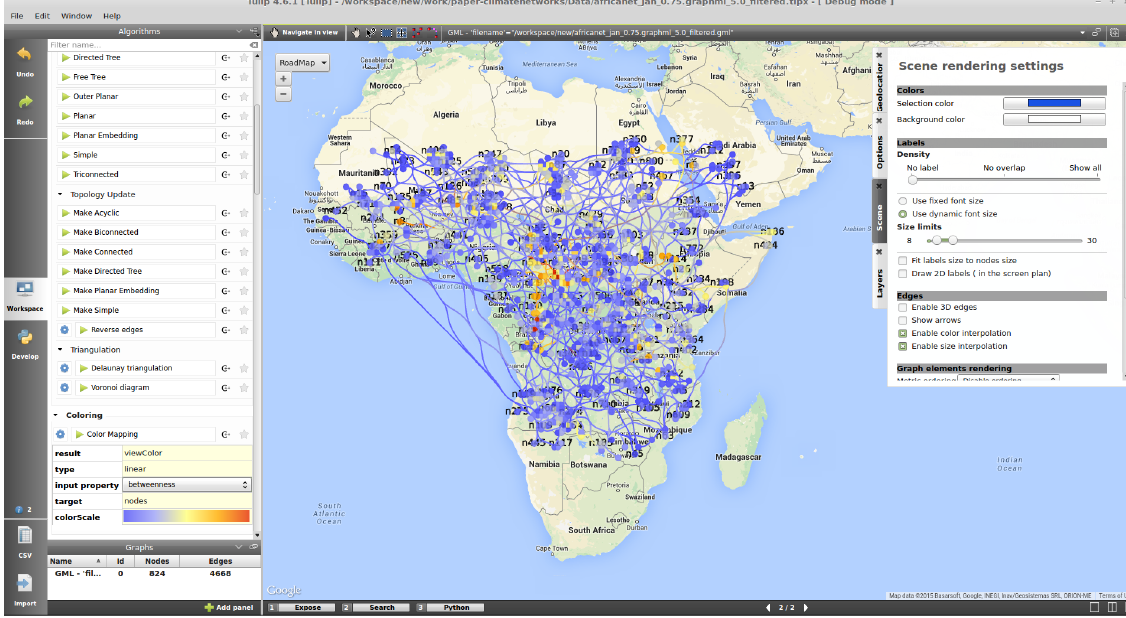
Figure 12. Tulip screenshot visualising the African January precipitation network (see Sect. 6.2), filtered by node betweenness ( ≥ 5.0) with edge bundling (edge routing) and node betweenness encoded in